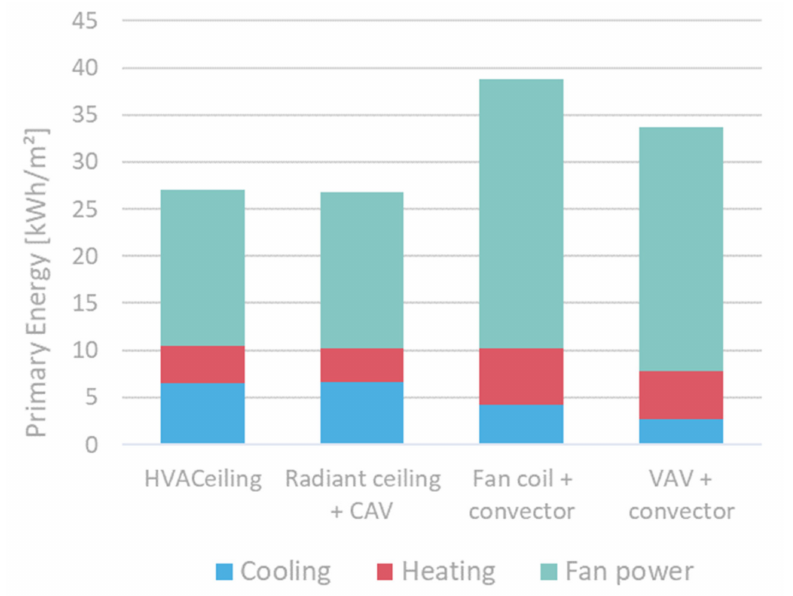
Figure 10. Primary energy use of heating, cooling, and ventilation installations through the year for four different types of